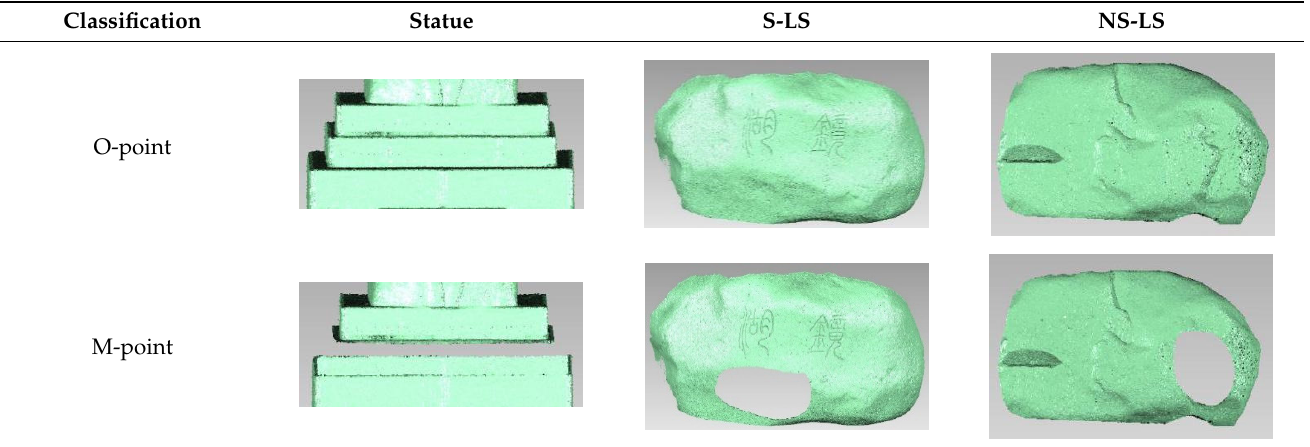
Table 2. Schematic of O-point and M-point.